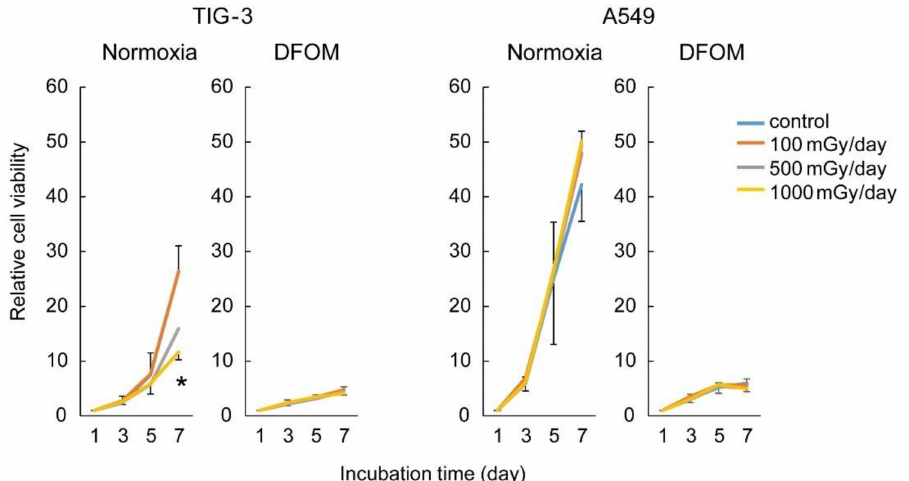
Figure 1. Effects of LDR-IR on cell proliferation. The relative cell viability of TIG-3 and A549 cells against LDR-IR under normoxic or hypoxia-mimicking (DFOM treatment) conditions was evaluated with the MTT assay. LDR-IR or DFOM treatment was started on Day 1, and the MTT assay was performed on Days 1, 3, 5, and 7. Values are means and SD ( n = 3); * p < 0.05 vs.